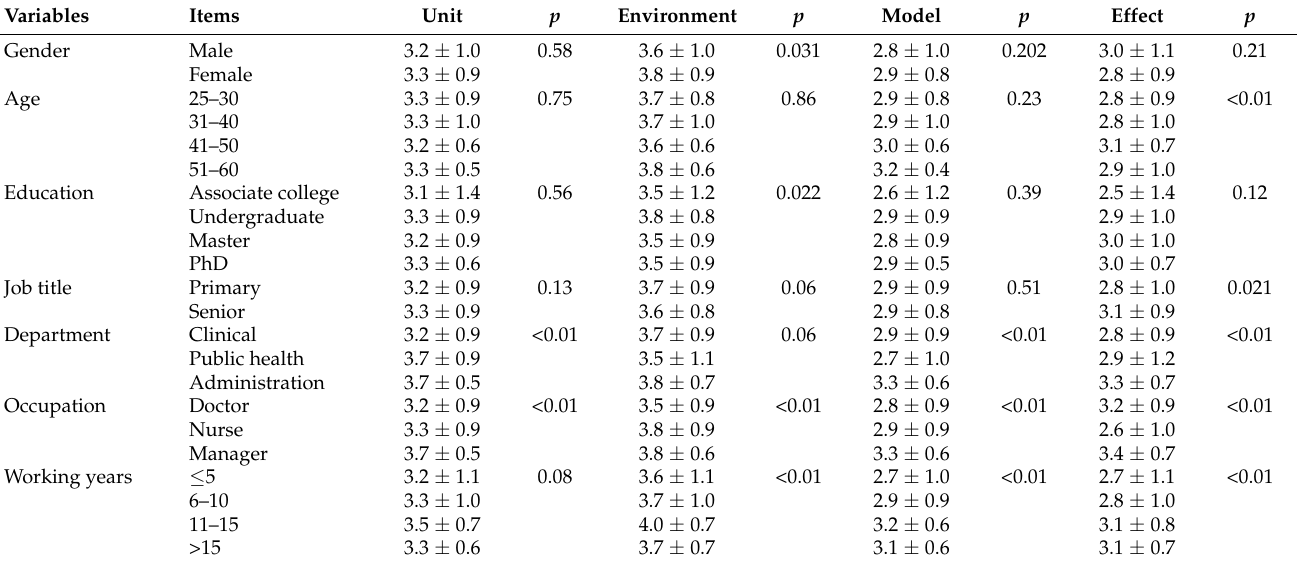
Table 5. Univariate analysis of the symbiotic unit, environment, model, and effect of the integration of medical care and disease